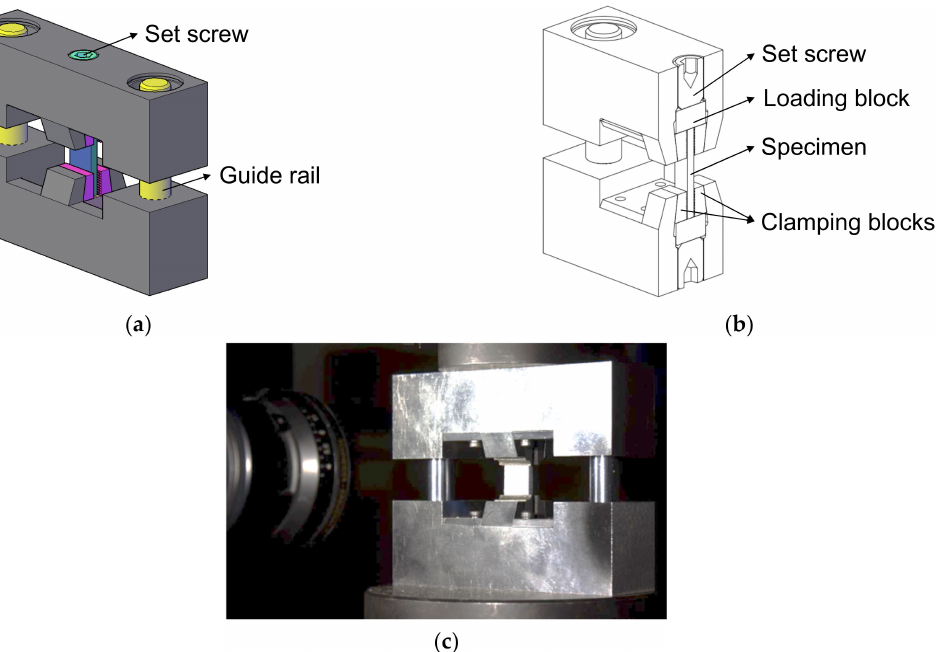
Figure 2. ( a ) The off-axis compression test fixture. ( b ) Sectional view of the off-axis compression test fixture. ( c ) The off-axis compression experimental